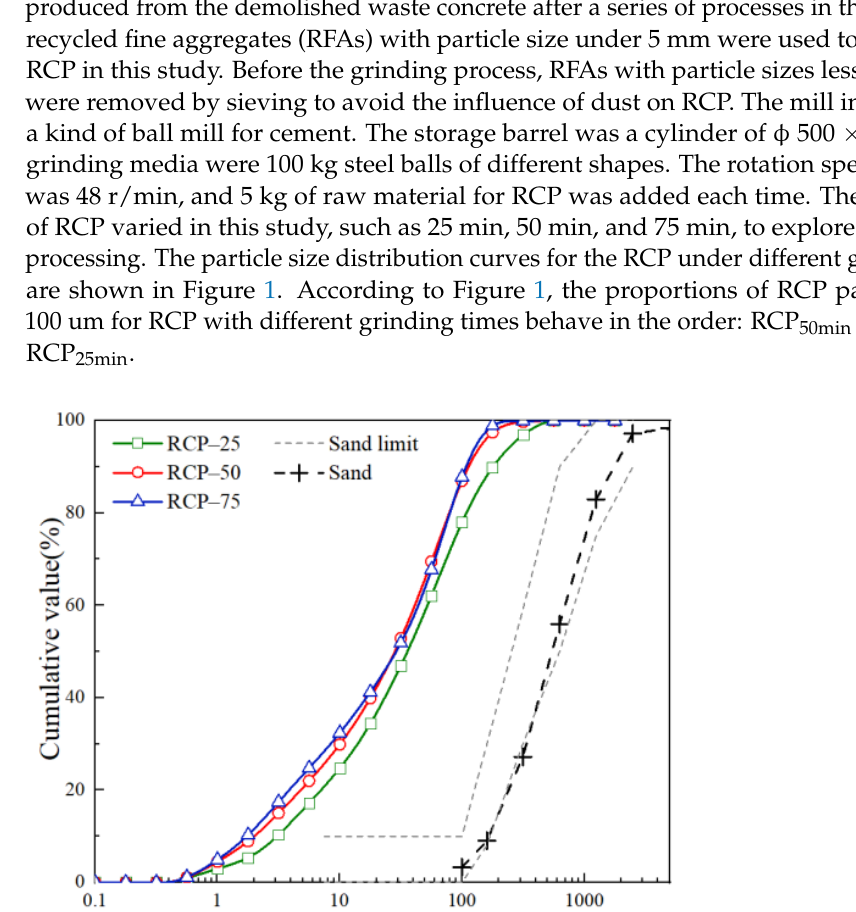
Table 1. Properties of cementitious materials (PC, SCGP, and RCP).